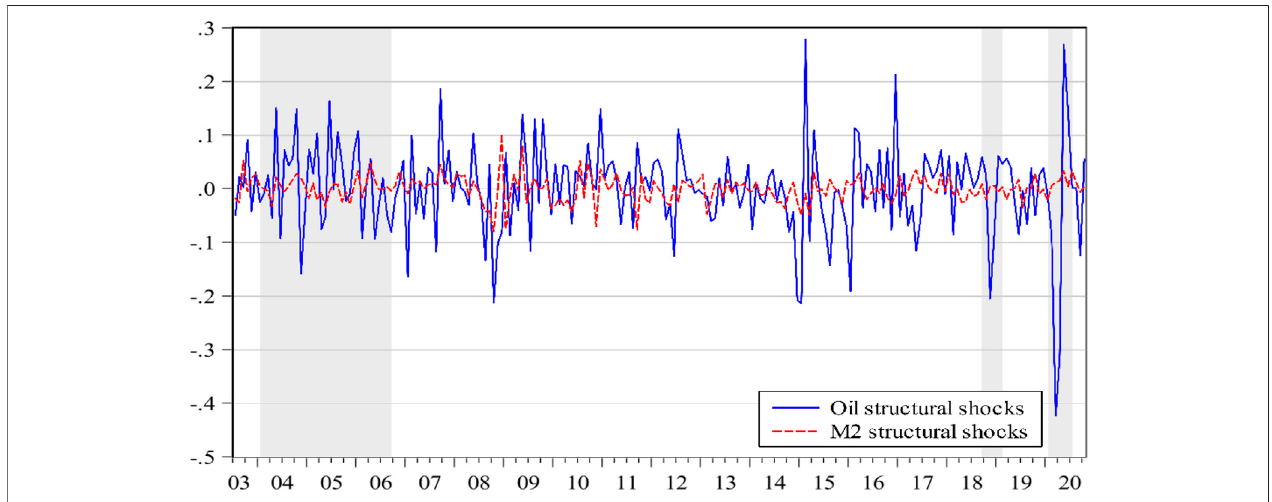
FIGURE 4 | Dynamic feature recognition of oil fi nancial attribute. Note: Shadow parts show negative relationship between the structural shocks of oil demand and monetary